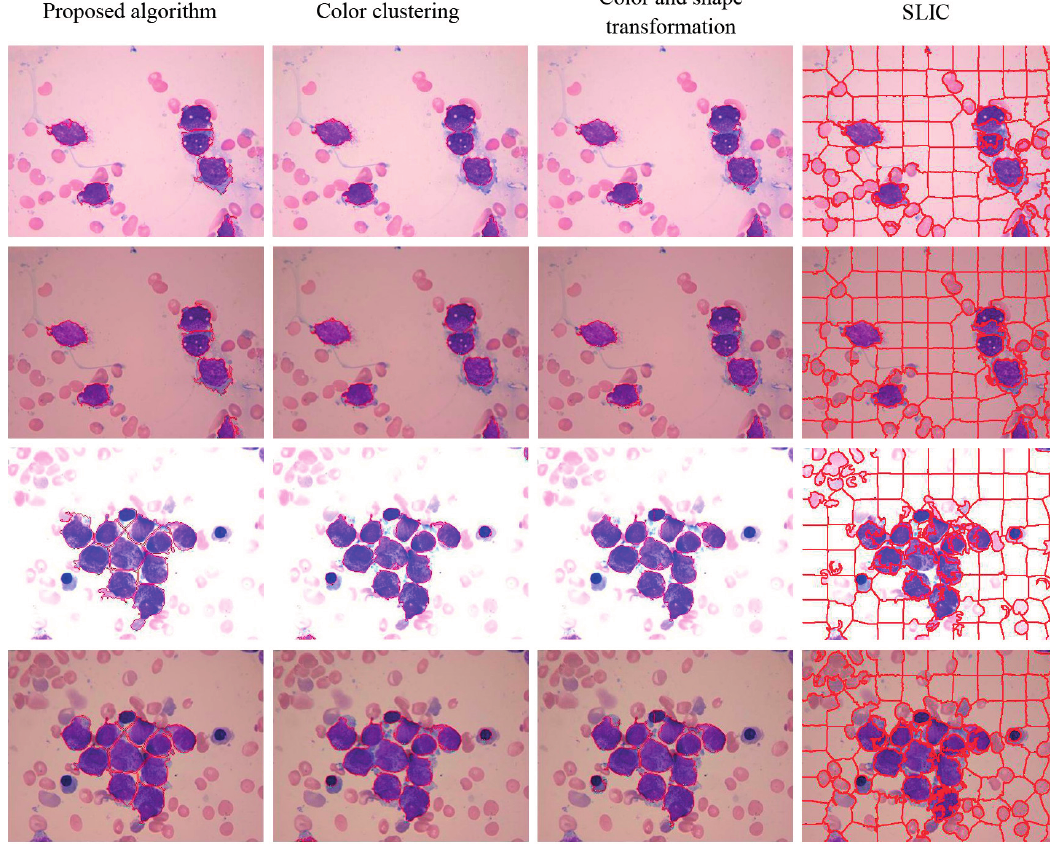
Figure 17. Two sets of Images under different light conditions (segmented WBCs marked with red